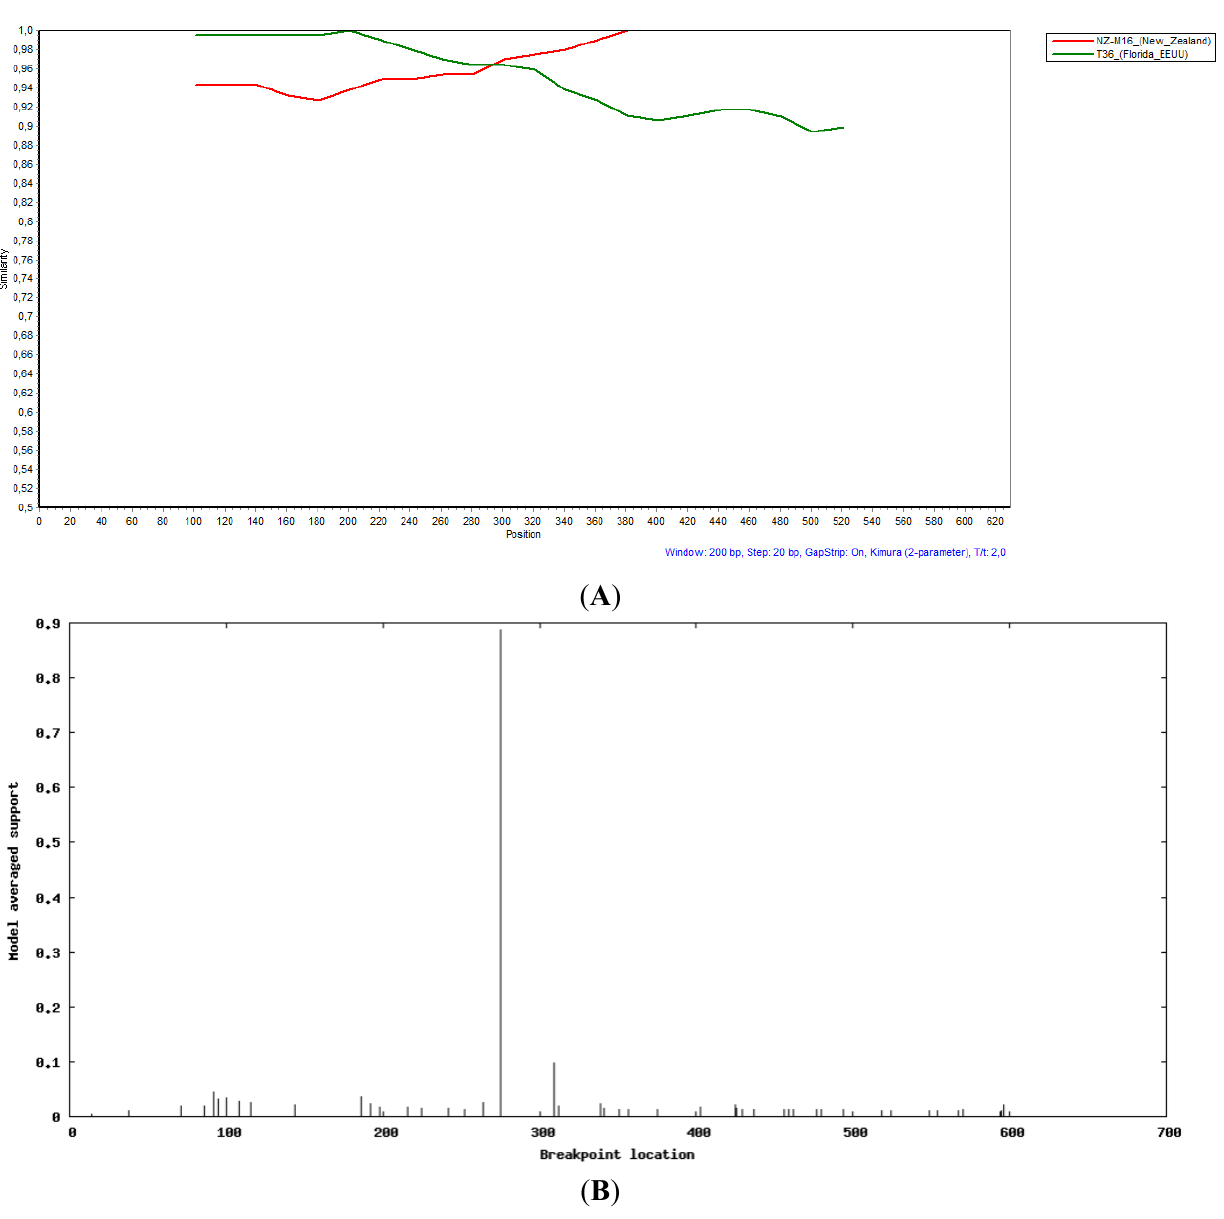
Figure 2. Evidence of recombination of clone 6 from sample 164 on p25 region between NZ-M16 and T36 isolates ( A ); Recombination point location detected by GARD tool ( B ).